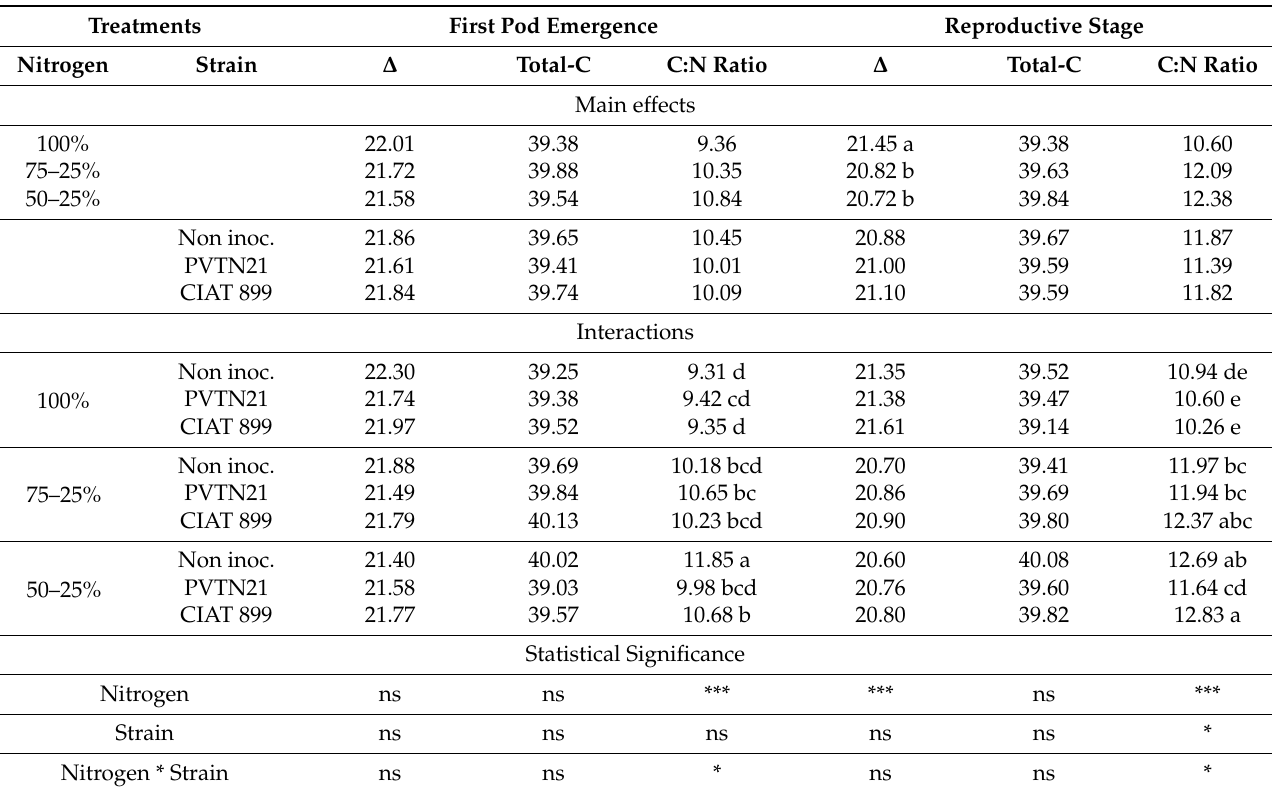
Table 2. Impact of mineral-N treatments and rhizobial inoculation on ∆ (‰), %C, and C:N ratio of common-bean ( Phaseolus vulgaris L.) shoots at different growth